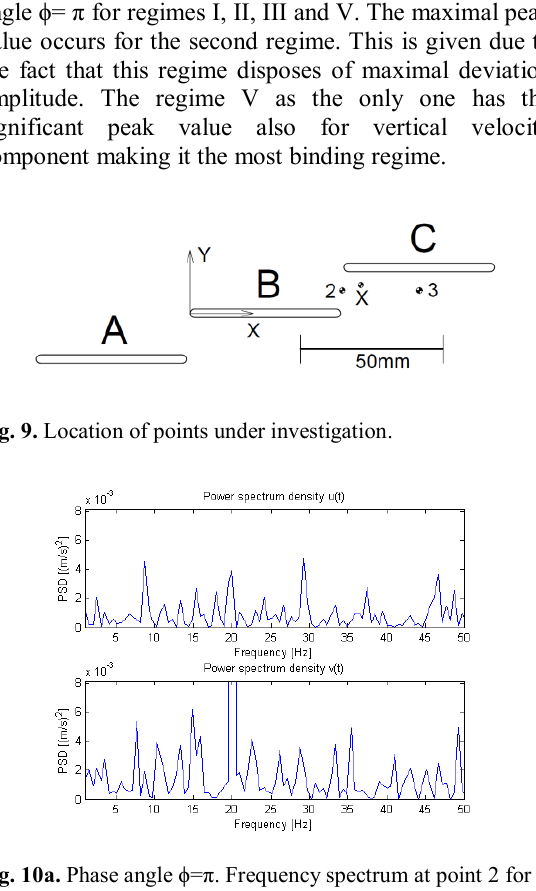
Fig. 10a. Phase angle ϕ=π . Frequency spectrum at point 2 for regime I.